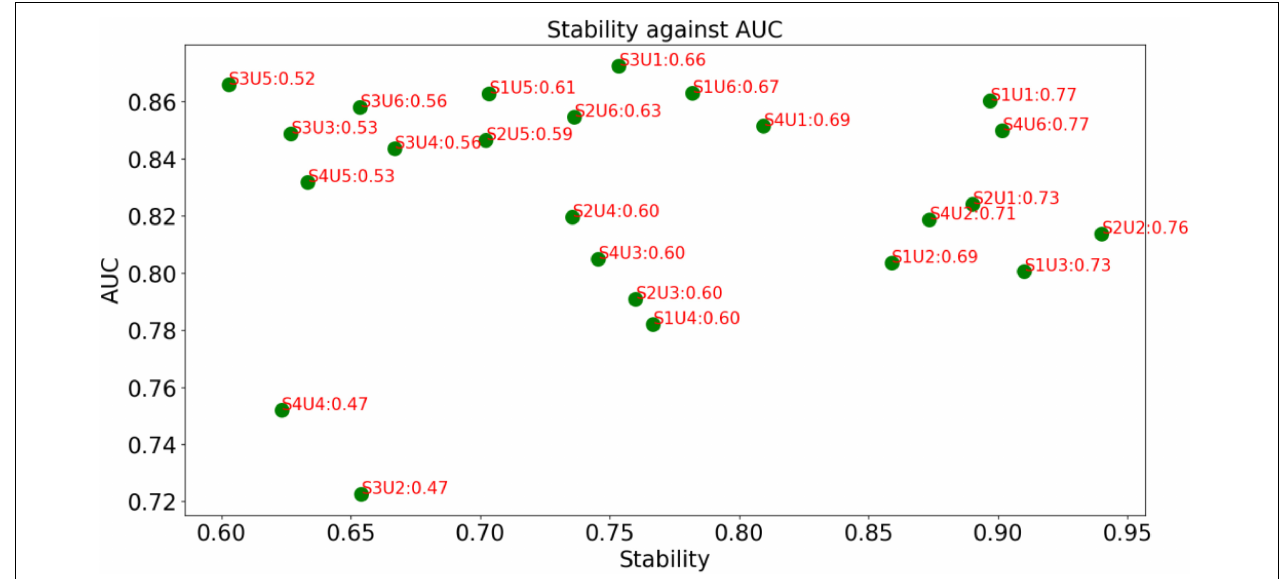
FIGURE 5 | Decision graph for PET